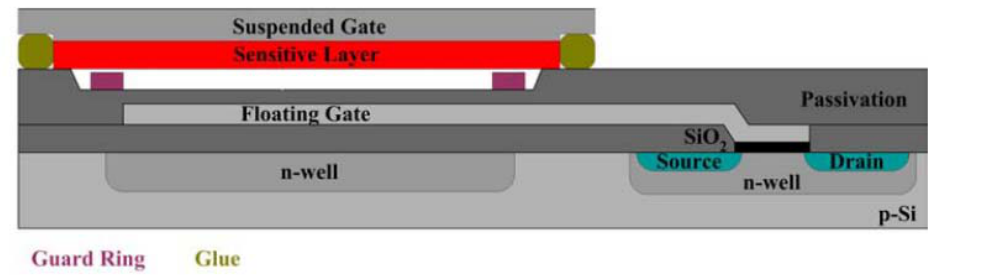
Figure 13. Schematic cross section of a floating gate (FGFET) type transducer that improves the coupling of the work function voltage to the FET. The capacitance well electrode can be additionally used to set the optimal working point in the transistor